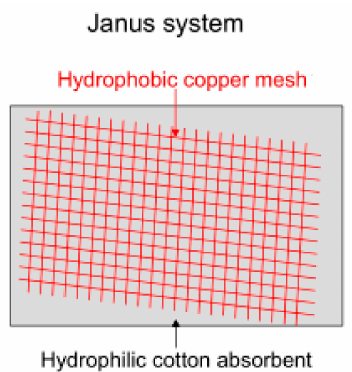
Figure 12. Structure schematic diagram of Janus System